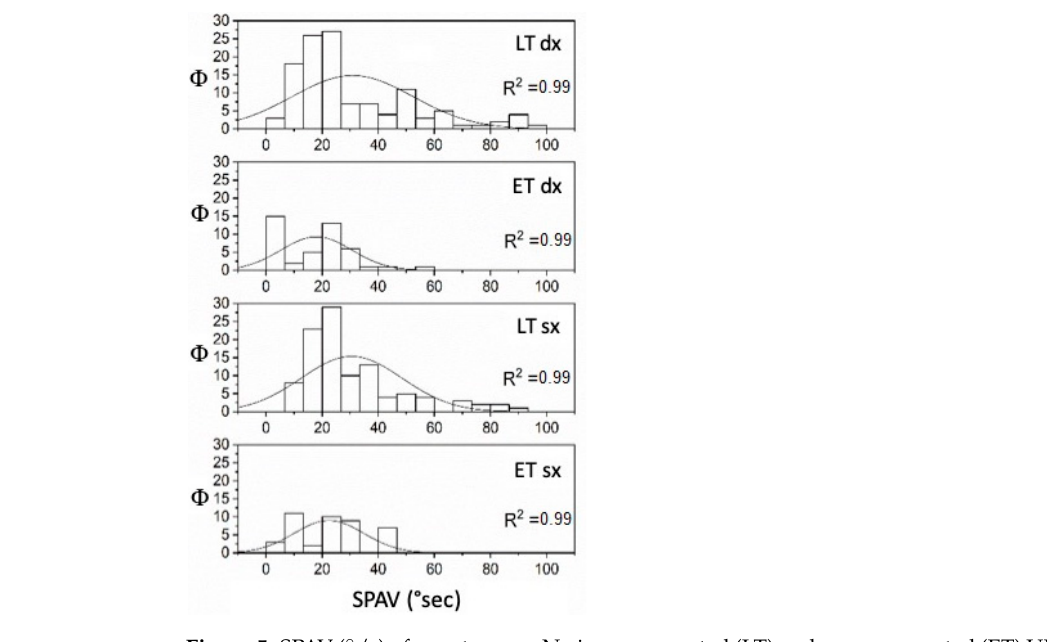
Figure 6. SPAV (°/s) of SVINT comparisons between UPVL and BPPV in older and younger patients ( Φ = data distribution frequency). The Gaussian peak represents the mean of SPAV in Hz. Frequency distribution and fitting analysis in fit R 2 = 0.99 for all curves except OP BPPV, that is R 2 = 0.98. ( p = 0.001).